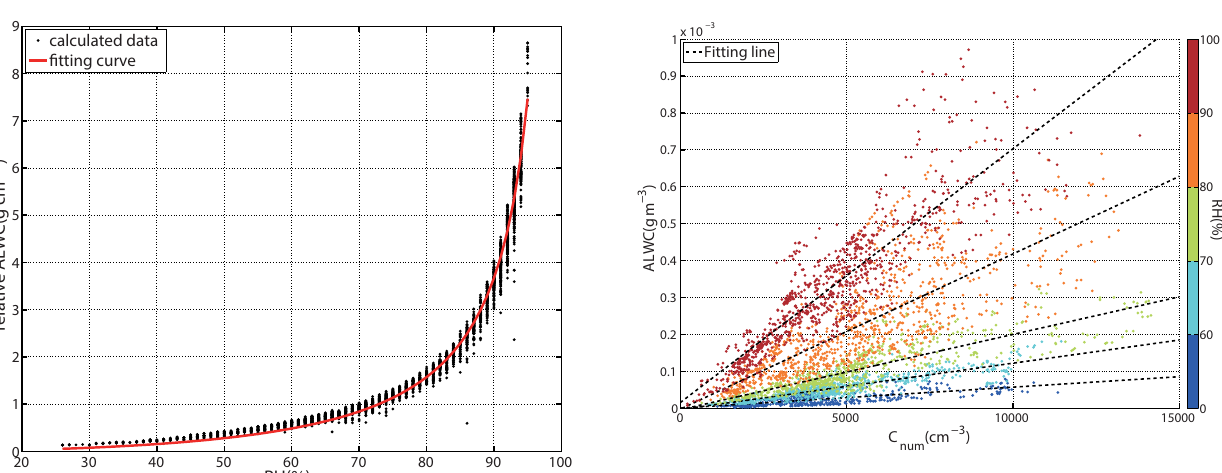
Figure 6. Coloured dots show the variation of the ALWC with cor- responding number concentrations of accumulation mode particles, with the colour segregated by the RH stages. The dashed lines rep- resent the fitting results in accumulation mode under varying RH conditions. Table 2. The coefficient of determination of each aerosol mode un- der different RH